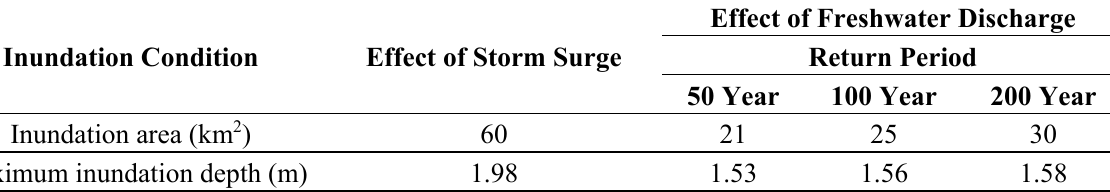
Table 2. Inundation area and maximum inundation depth under different